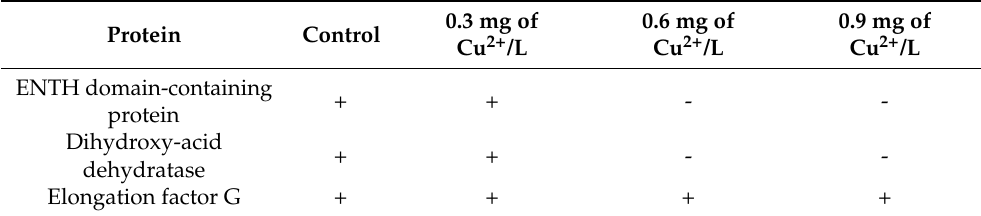
Table 2. Identified proteins related to protein biosynthesis. Protein